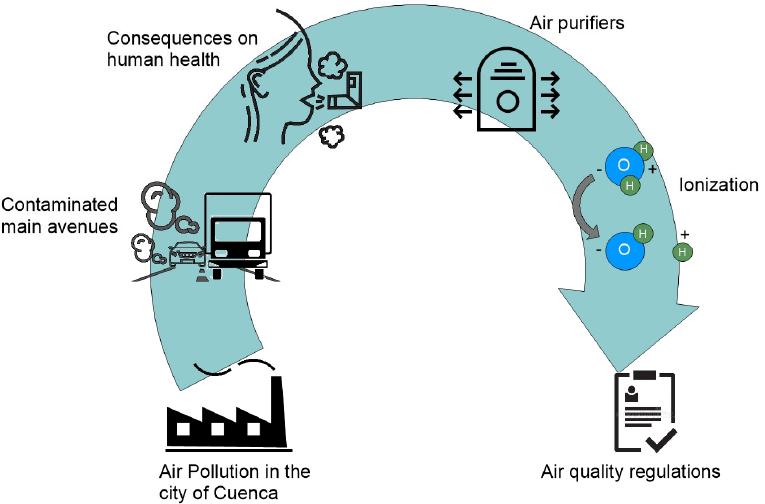
Figure 1. Sequence of the bibliographic analysis.